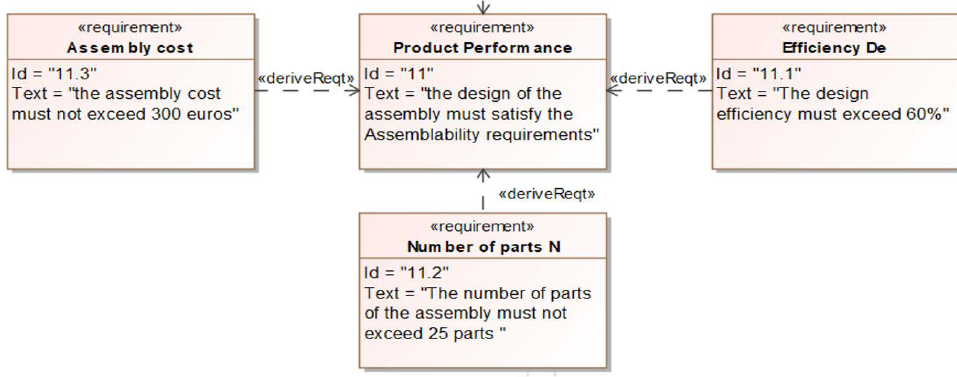
Figure 4. Product performance requirements of the speed